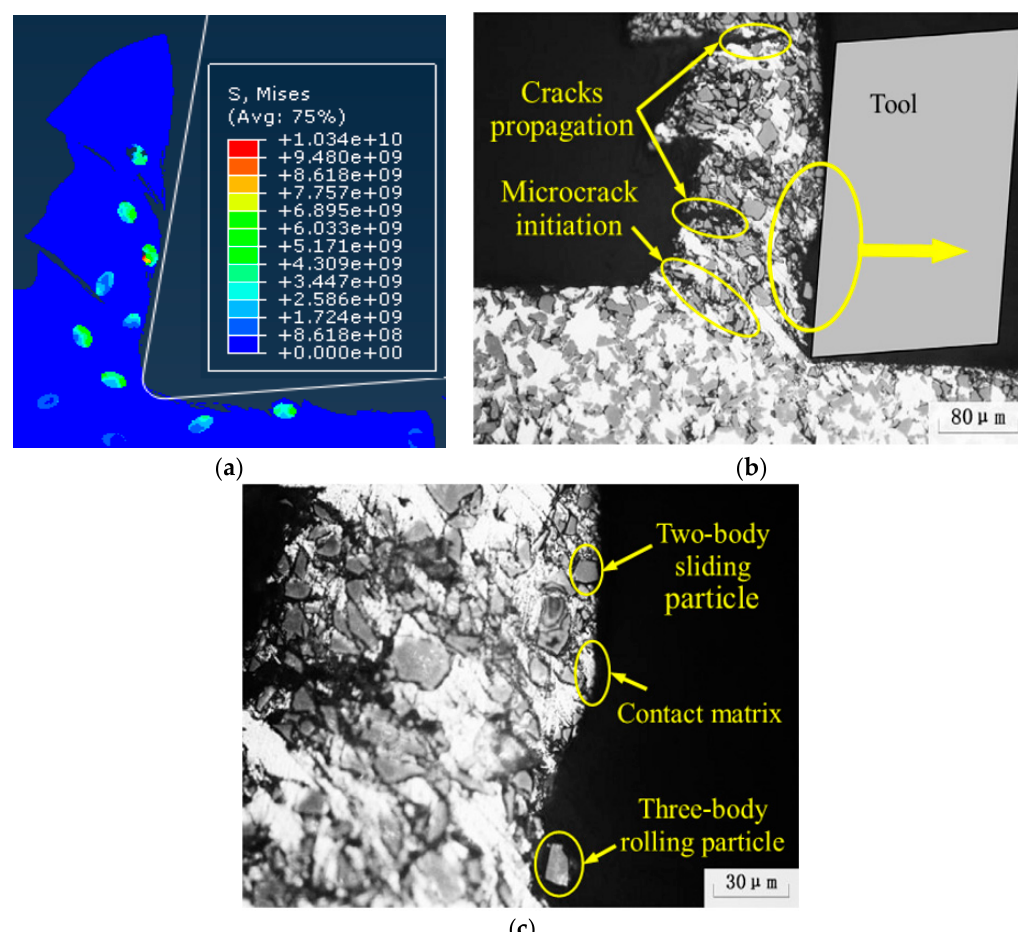
Figure 30. The chip morphology varies with particle size and cutting parameters: ( a ) The simulation of the chip formation of SiCp/Al. However, Chip formation in the machining of 2024Al/40%SiC-30 μ m composites cutting speed of v c = 120 m/min and feed rate of f = 0.1 mm/rev, ( b ) a micrograph of the chip root, ( c ) an enlarged view of the three-phase friction at the tool–chip. ( b , c ) Adapted with permission from ref. [50] Copyright 2018, Elsevier.